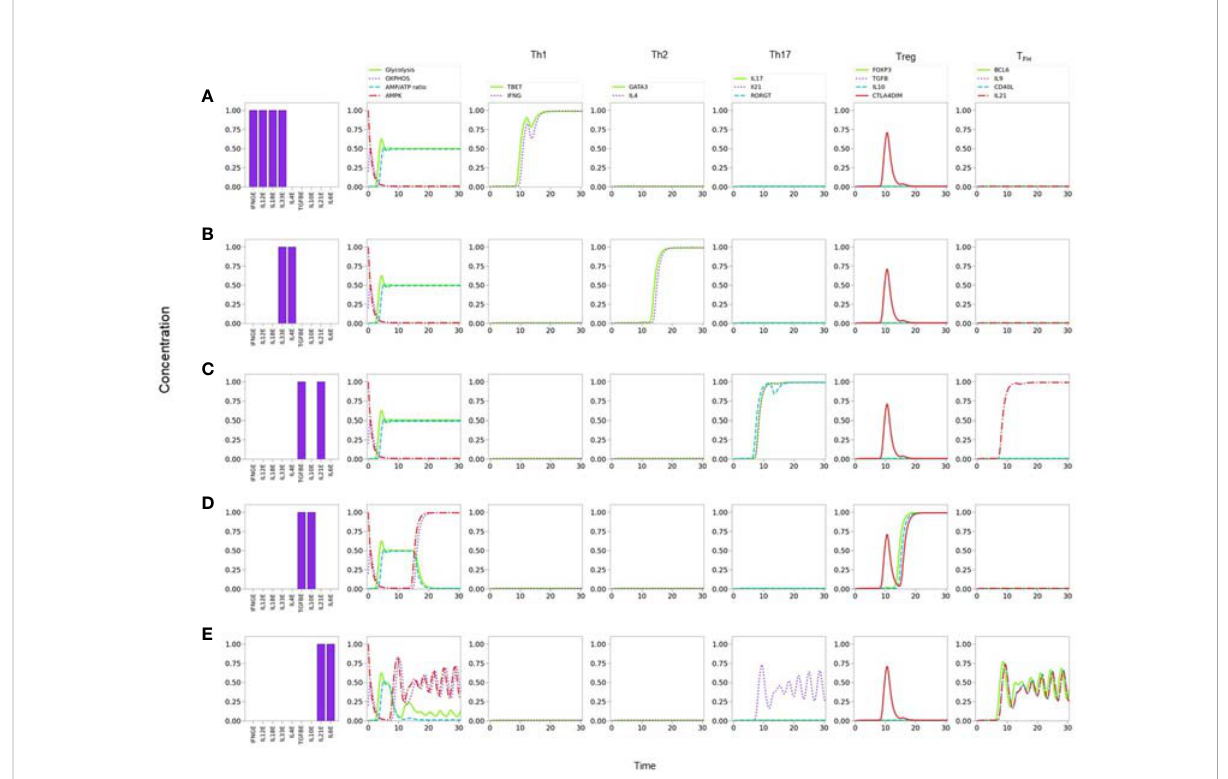
FIGURE 6 Line plots of CD4 + T cell differentiation and metabolic dynamics induced by speci fi c lineage-inducing cytokine microenvironments (as indicated in histograms) and optimal nutrient and oxygen conditions. (A) Th1 polarization characterized by sustained expression of T-bet and IFN- g . (B) Th2 polarization characterized by sustained expression of GATA-3 and IL-4. (C) Th17 polarization characterized by sustained expression of ROR g T, IL-17 and IL-21. (D) Treg polarization characterized by sustained expression of Foxp3 and IL-10. (E) T FH polarization characterized by sustained periodic expression of Bcl-6, IL-9, IL-21, and CD40L. Similarly, a periodic oxidative metabolism is also observed, preceded by a transient glycolytic